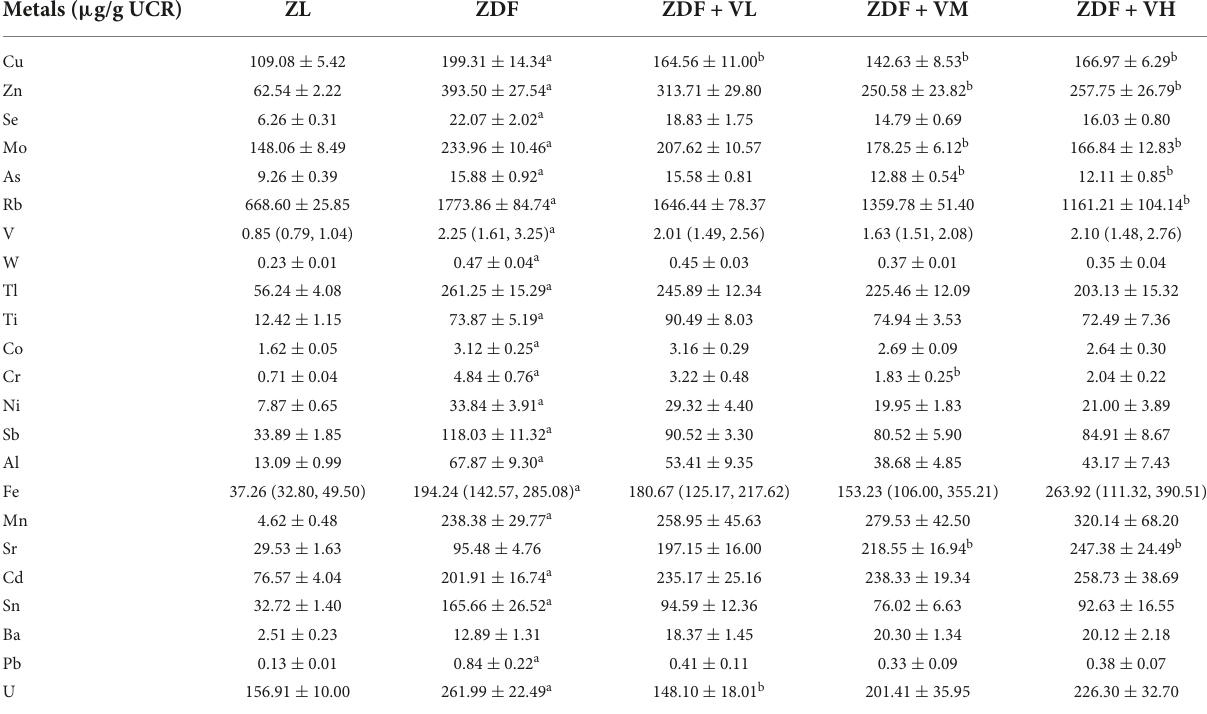
TABLE 4 Effects of 1,25(OH) 2 D 3 on urine metal concentration of Zucker rats in the sixth week of treatment. Metals ( µ g/g